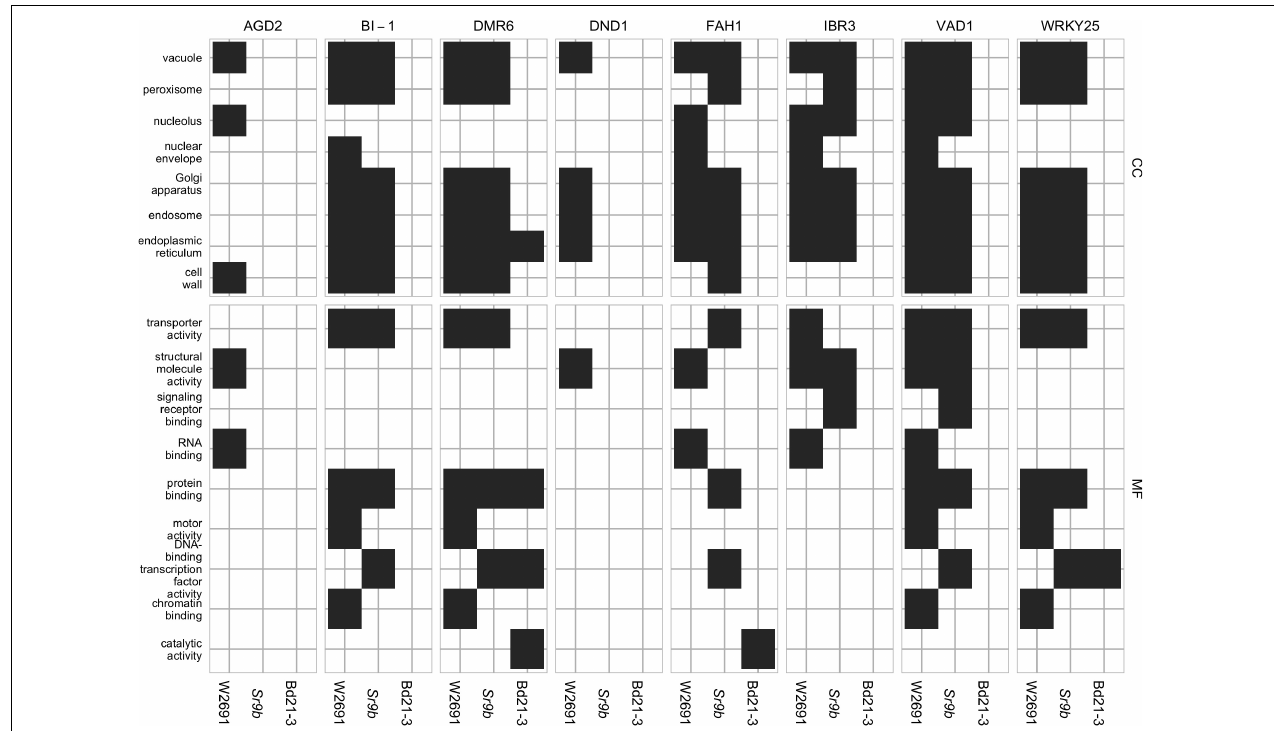
FIGURE 5 | GOslim term enrichment for all genes in co-expression gene clusters containing S gene orthologs in T. aestivum and B. distachyon . The y-axis shows GOslim terms separated into categories: cellular component (CC) and molecular function (MF).